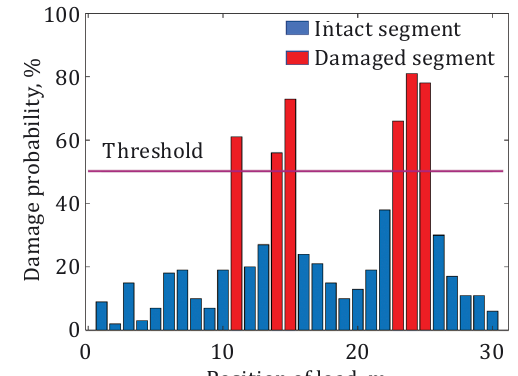
Figure 14. Damage probability along span direction Position of load,